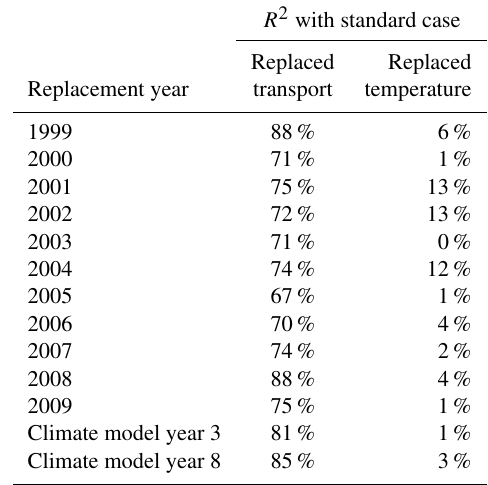
Table 1. Coefficient of determination ( R 2 ) values for the standard and replaced cases in ERA-Interim over the period 1999–2009, and two cases from the climate model simulation. Values are calculated using monthly mean time series with the climatological annual cy- cle